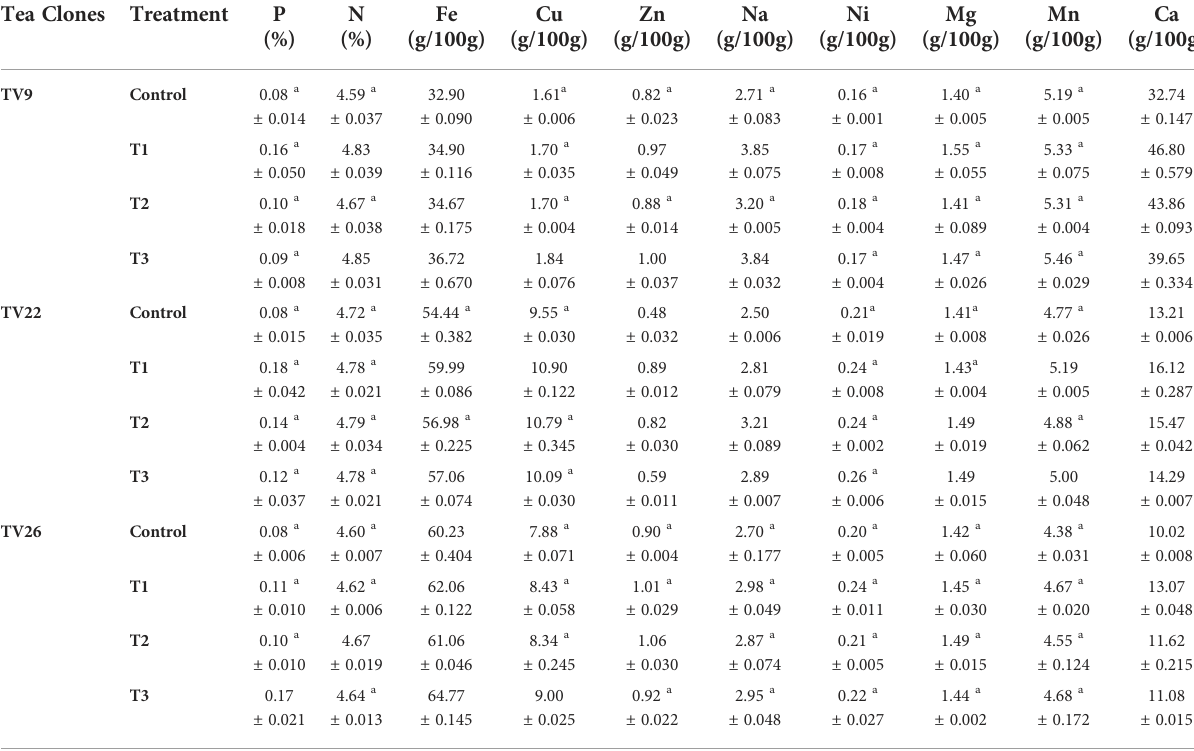
TABLE 7 Element concentration in the shoots of tea clones inoculated under nursery conditions with potent actinobacterial strains. Tea Clones